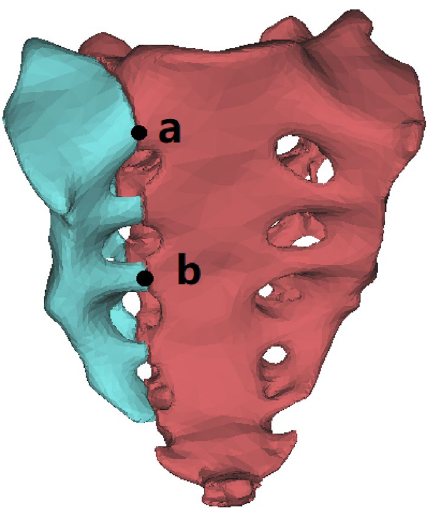
Figure 2. A vertical fracture line was made through the right sacral foramen and points a and b were marked on the fracture line.